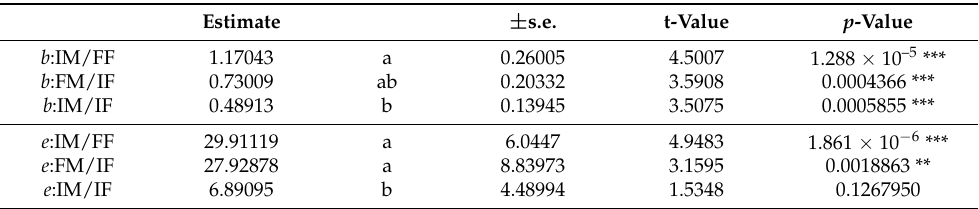
Table 3. Model fitted for % of response: Weibull (type 1) with a lower limit at 0 and with the intercept fixed to 100% (crossings of Bagrada hilaris : IM/FF: irradiated virgin male × fertile virgin female; FM/IF: fertile virgin male × irradiated virgin female; IM/IF: irradiated virgin male × irradiated virgin female). The parameter b describes the slope, while the parameter e is the inflection point of the curve. Parameters followed by different letters are significantly different for p = 0.05 according to the t-statistics.